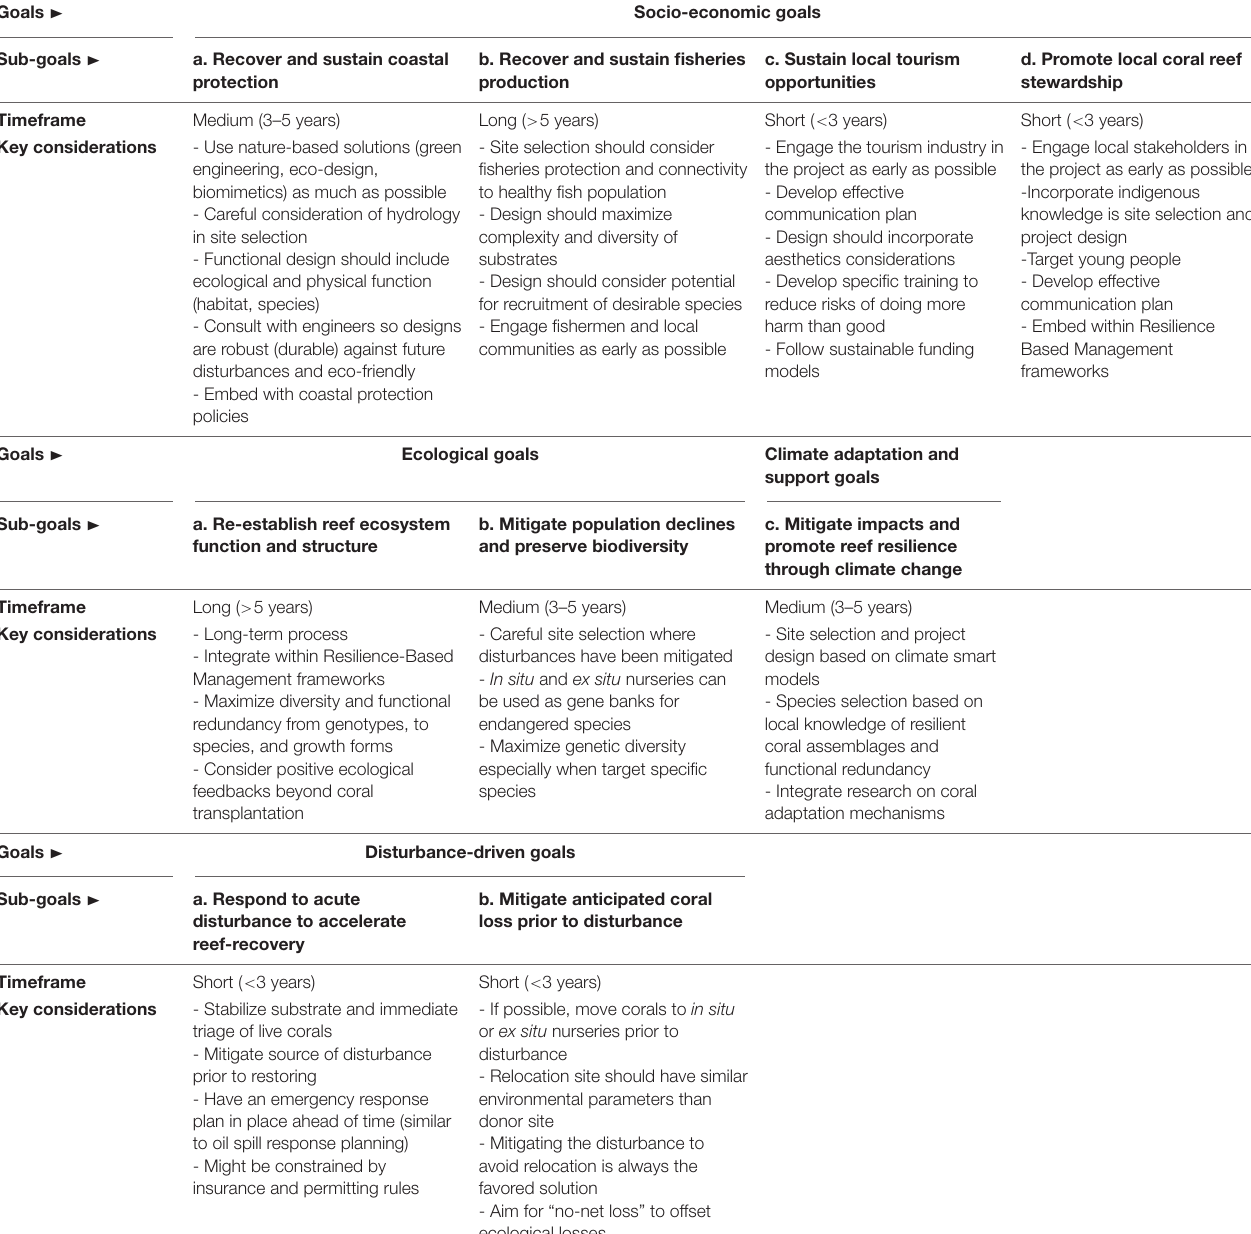
TABLE 3 | Key considerations for applying coral reef restoration to satisfy specific